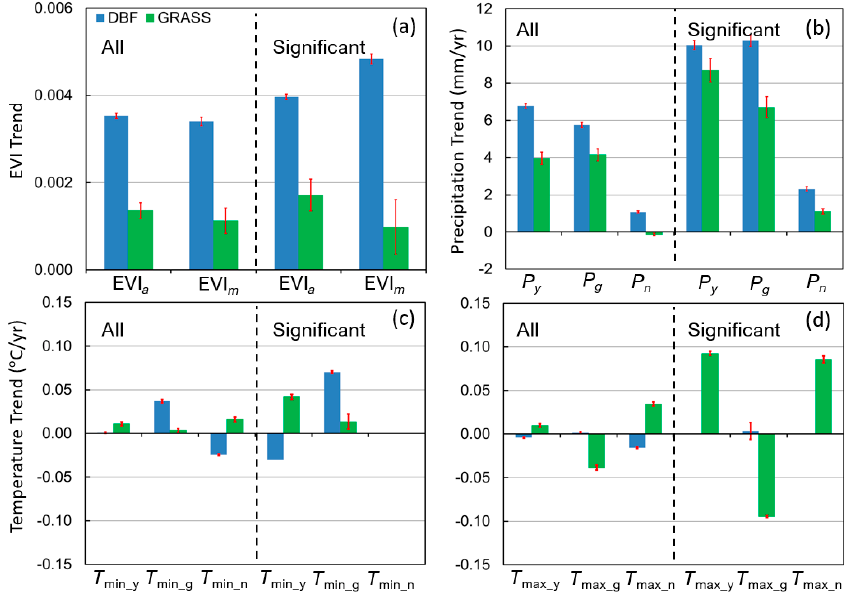
Figure 3. Average and stand error of slopes of mean and maximum EVI during May–September ( a ), and slopes of climate variables in wet-year (prior October to this September), growing-season, and nongrowing-season precipitation ( b ), minimum temperature ( c ), and maximum temperature ( d ) in 2001–2015 for grassland (GRASS) and deciduous-broadleaved forest (DBF) patches. EVI a and EVI m indicate averaged and maximum EVI during growing season, respectively; P , T min , T max indicate precipitation, minimum, and maximum temperatures, respectively; and y, g, and n indicate wet-year, growing-season, and nongrowing-season, respectively. Summary of all trends is displayed on the left side of the dashed line and summary over the significant trends, i.e., significantly lower than 0 or significantly greater than 0 ( p -value < 0.05, one-tail test), is shown on the right side of the dashed lines.